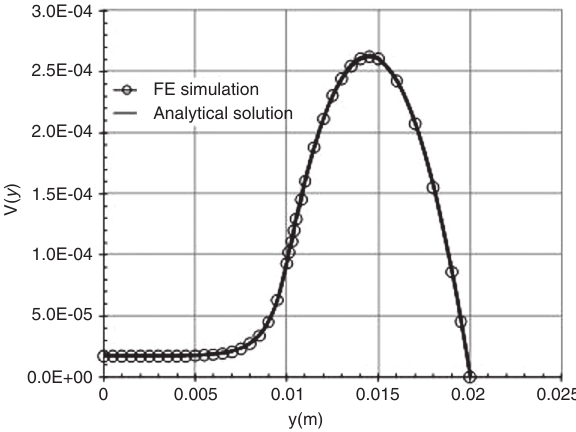
Figure 11 Schematic representation of the axisymmetric half section of the single fiber and